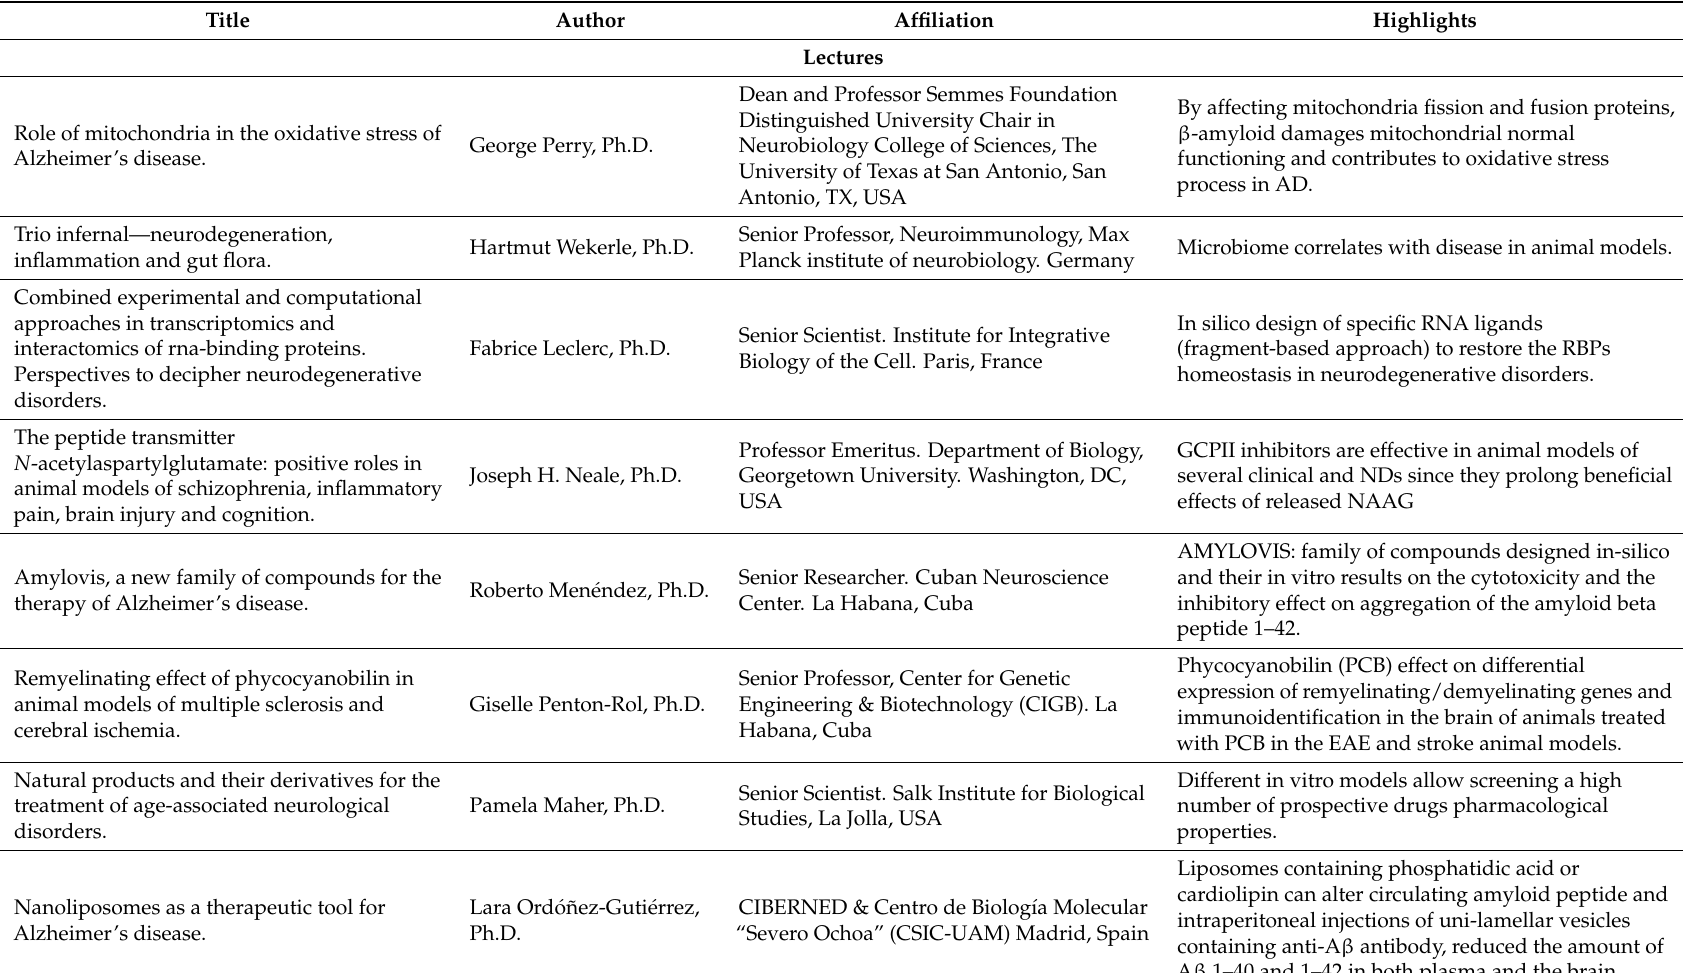
Table 1. Symposium’s short report and lectures